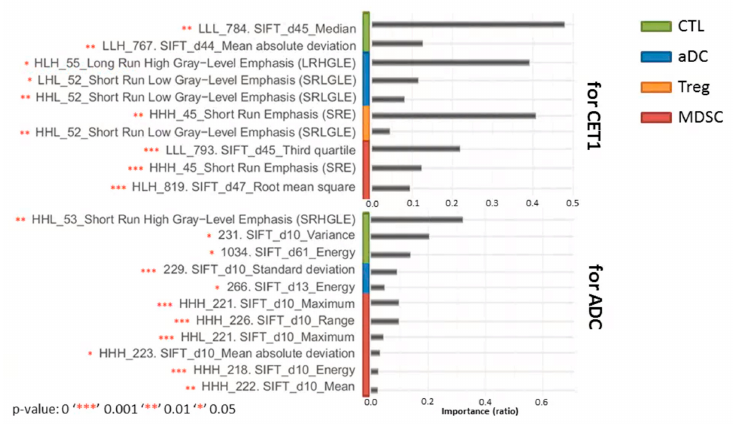
*LRHGLE: Long run high gray-level emphasis; SRLGLE: Short run low gray-level emphasis; SRE: Short run emphasis; SRHGLE: Short run high gray-level emphasis; IMC1: Informational measure of correlation 1 Figure 7. Statistical significance of radiomic features for different models. A chi-squared test was used to evaluate the importance of features for models. Number of stars indicates the extent of statistical significance had by features for each model. (For instance, one star “*” means p value < 0.05 and so on.) Otherwise, the importance ratio of features represented the features’ effectiveness relative to other features in the same models.